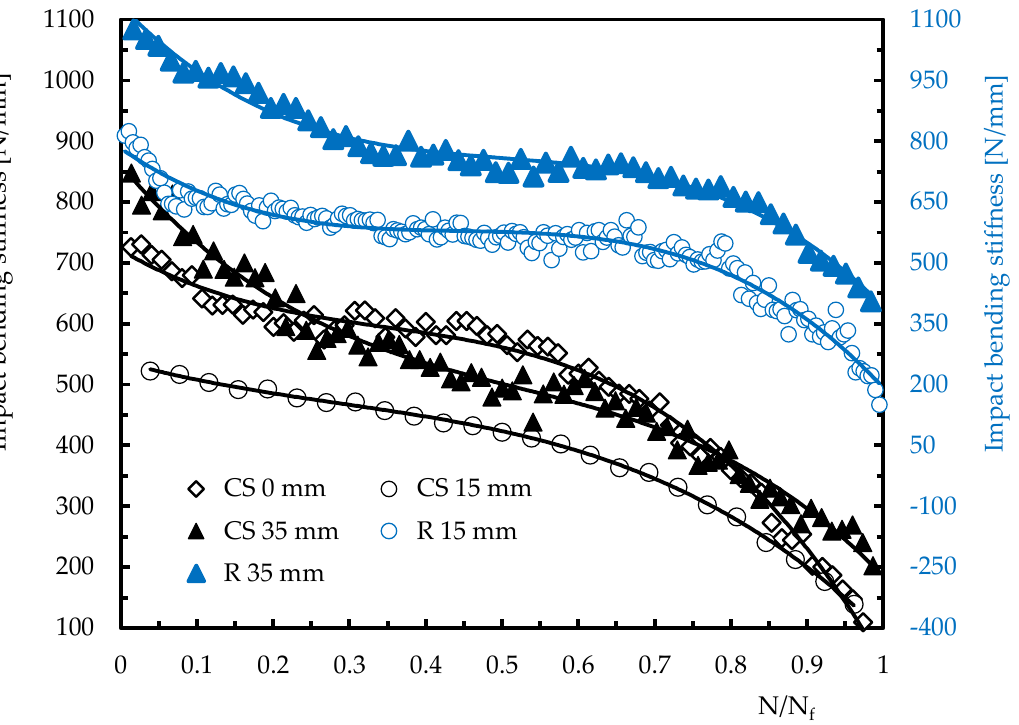
Figure 7. Impact bending stiffness versus number of impacts for different geometries and distances.